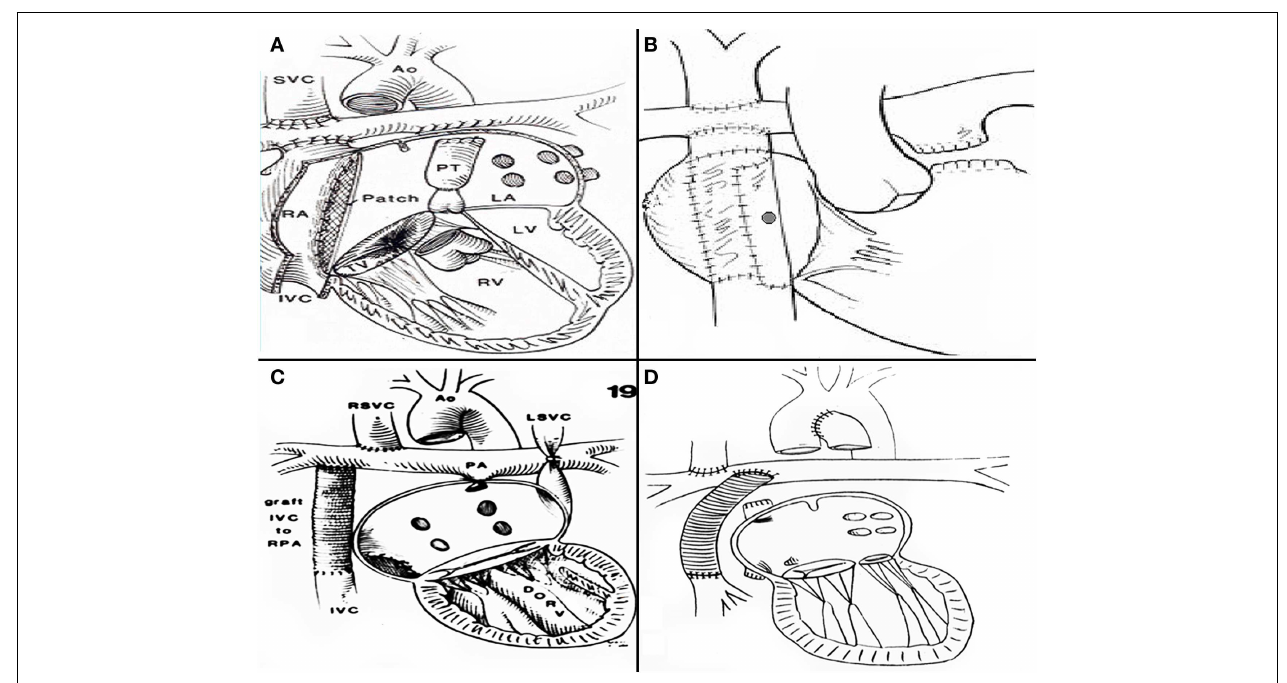
FIGURE 4 | (A) De Leval’s total cavopulmonary connection (B) fenestrated lateral tunnel technique. (C) Puga´s extracardiac conduit technique (D) Marcelleti´s extracardiac conduit technique.